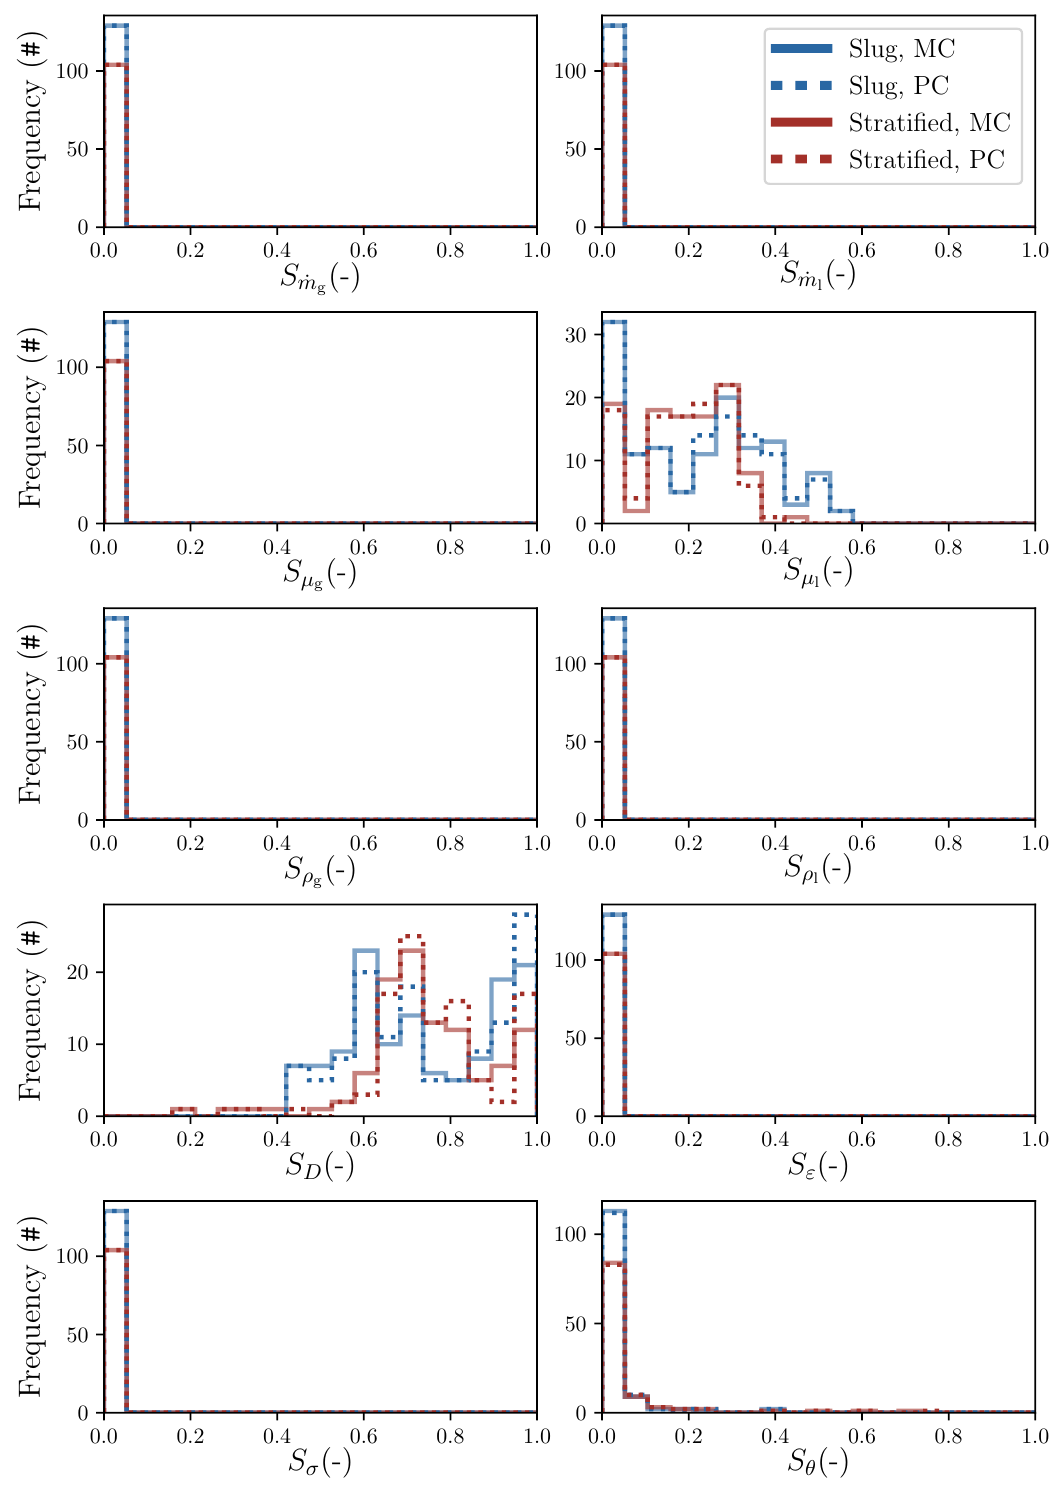
Figure 8. Frequency histograms of the pressure drop sensitivity estimates across 233 experiments. The sensitivity distribution for one input variable is given in each panel. The experiments are categorized as slug (blue) or stratified (red), and we compare estimates from Monte Carlo (solid lines) and PC